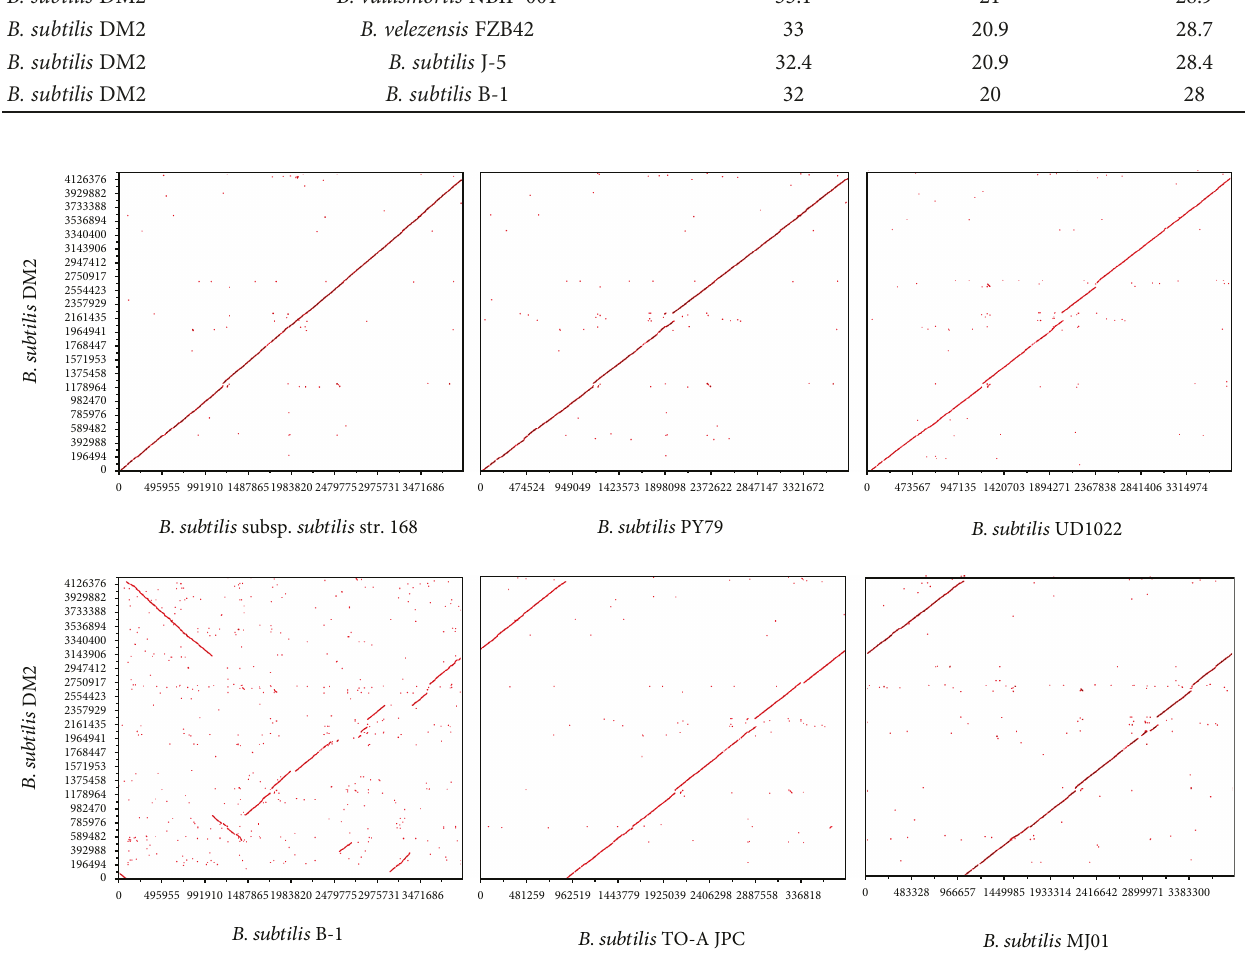
Figure 3: Ortholog dot plot of B. subtilis DM2 genome vs. B. subtilis PY79, B. subtilis subsp . subtilis str. 168, B. subtilis UD1022, B. subtilis B-1, B. subtilis TO-A JPC, and B. subtilis MJ01 genomes. Each dot represents a reciprocal best hit by